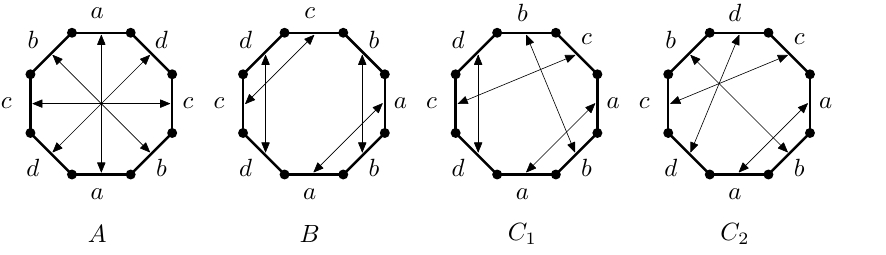
Figure 2. Octagon pastings of genus 2. Table 3. Gaussian words and automorphism